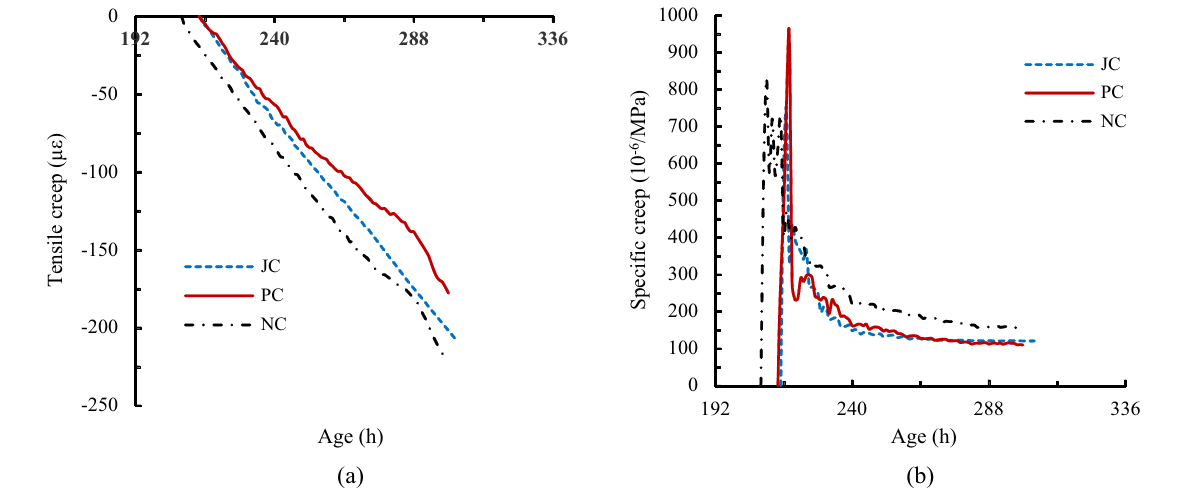
Figure 7: ( a ) Tensile creep and ( b ) speci fi c creep, for three concretes under TMC